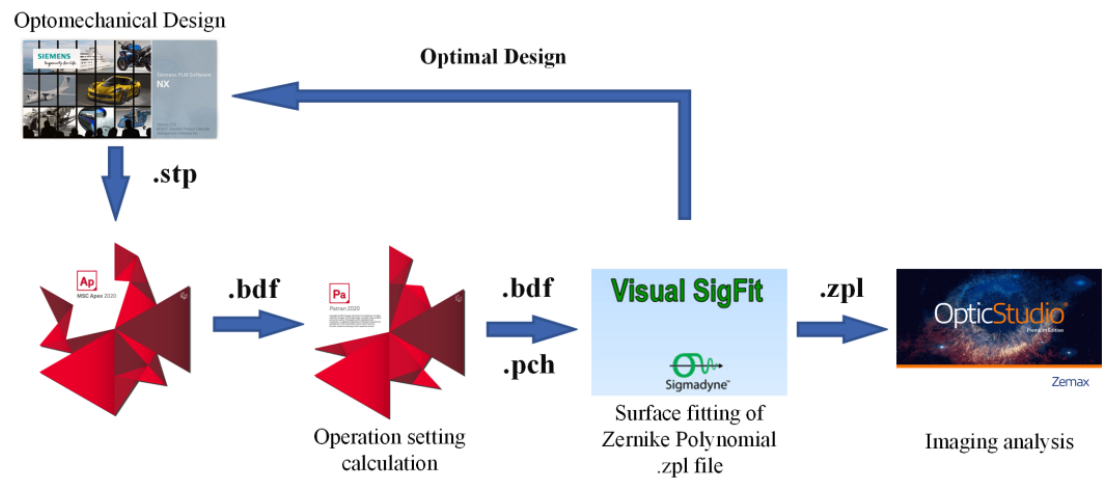
Figure 6. Integrated optomechanical analysis method and process.